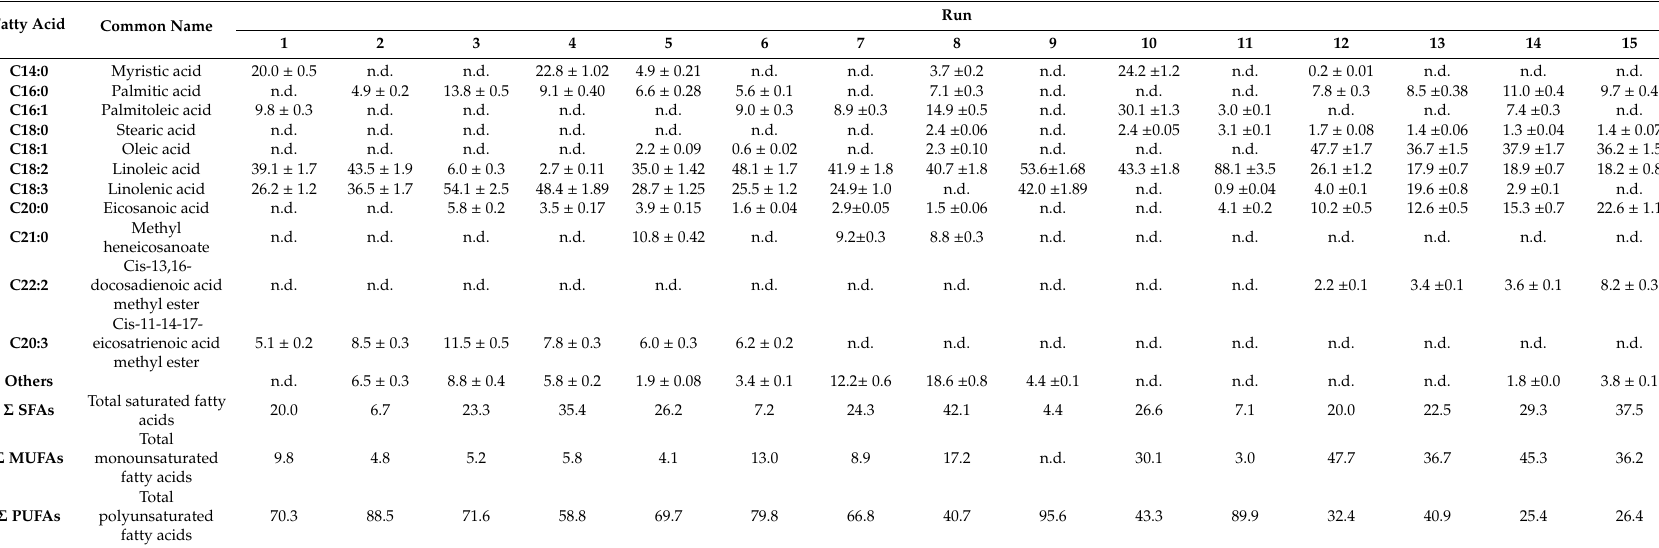
Table 3. Fatty acid composition and content of SFE extracts from freeze-dried Isochrysis galbana used in this study (% area of total FAME and mg FAME / g). The general parameters were biomass loading = 2.0 g, CO 2 flow rate = 7.4 g / min, extraction time = 120 min (SD ≤ 5%; n =